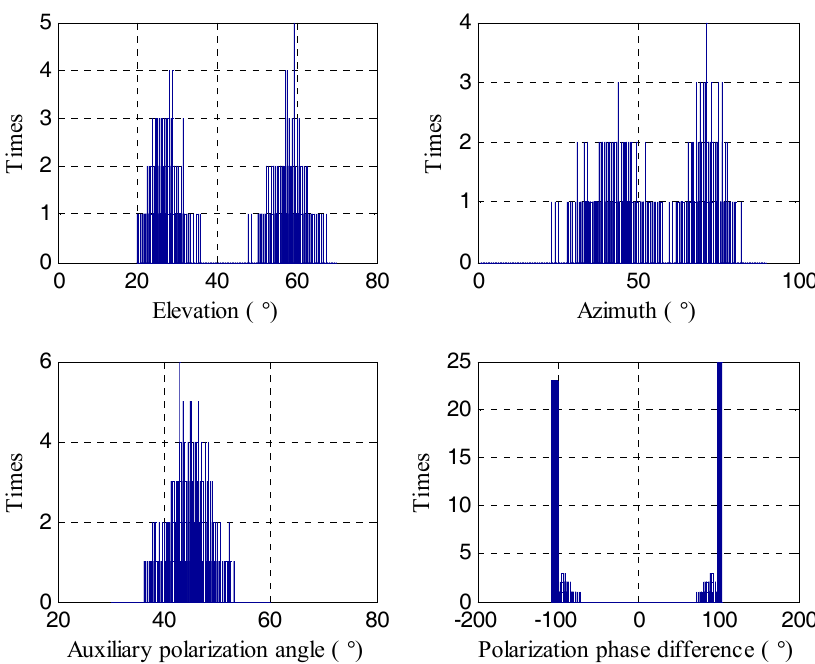
Figure 5. The estimation result of the algorithm of [26].